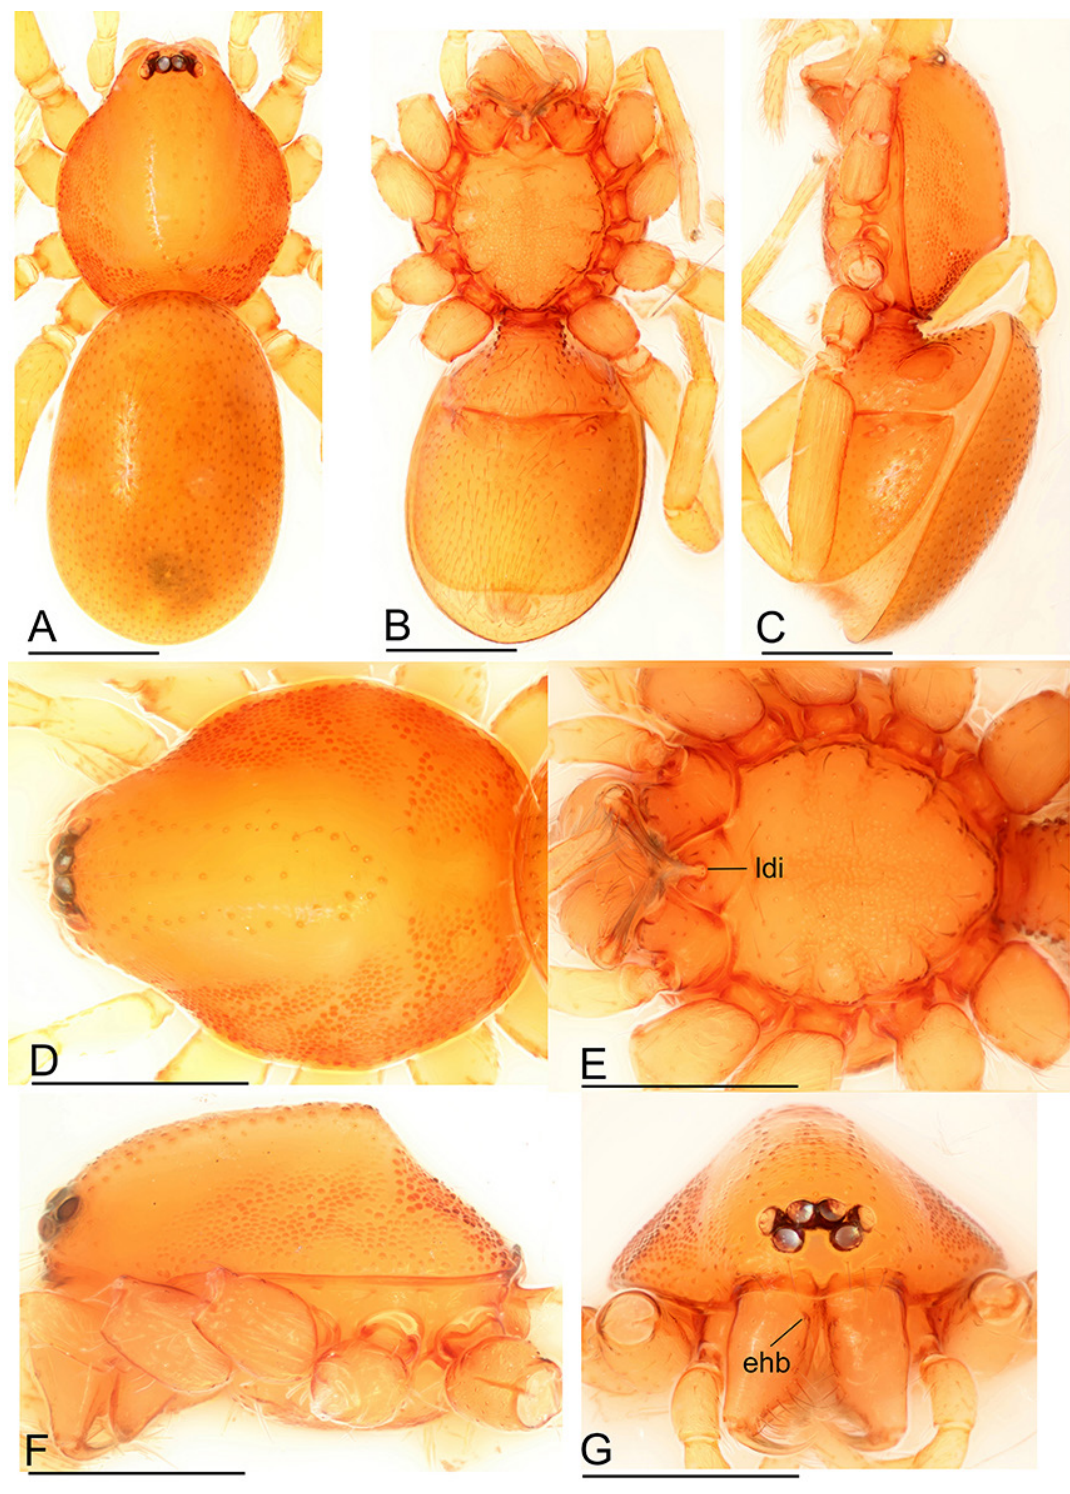
Fig. 7. Trilacuna jiuchi Tong, Zhang & Li sp. nov., paratype, ♀ (SYNU-303). A – C . Habitus in dorsal, ventral, and lateral views. D – G . Prosoma in dorsal, ventral, lateral, and anterior views. Abbreviations: ehb = elevated hair base; ldi = labium deep incision. Scale bars: 0.4